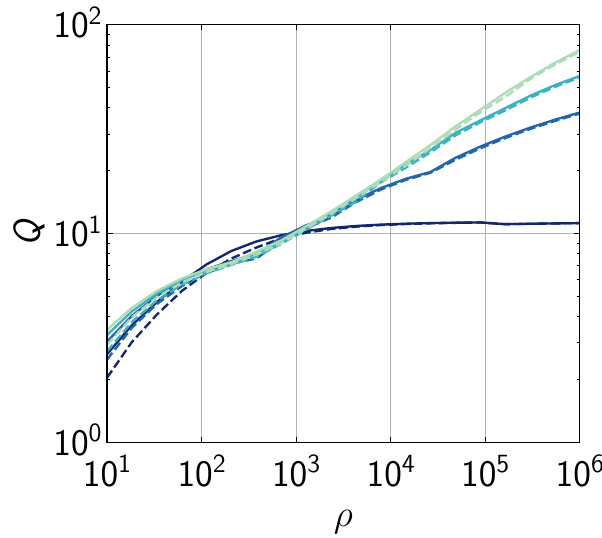
FIG. 8. Comparison of speedups Q between two diffusion operator methods: Q versus the interaction-to-decay ratio ρ for the perfect diffusion operator (full lines) and the diffusion oper- ator using the generalized oracle (dashed lines) for n = k = ( 4, 6, 8, 10 ) , shaded from darkest to